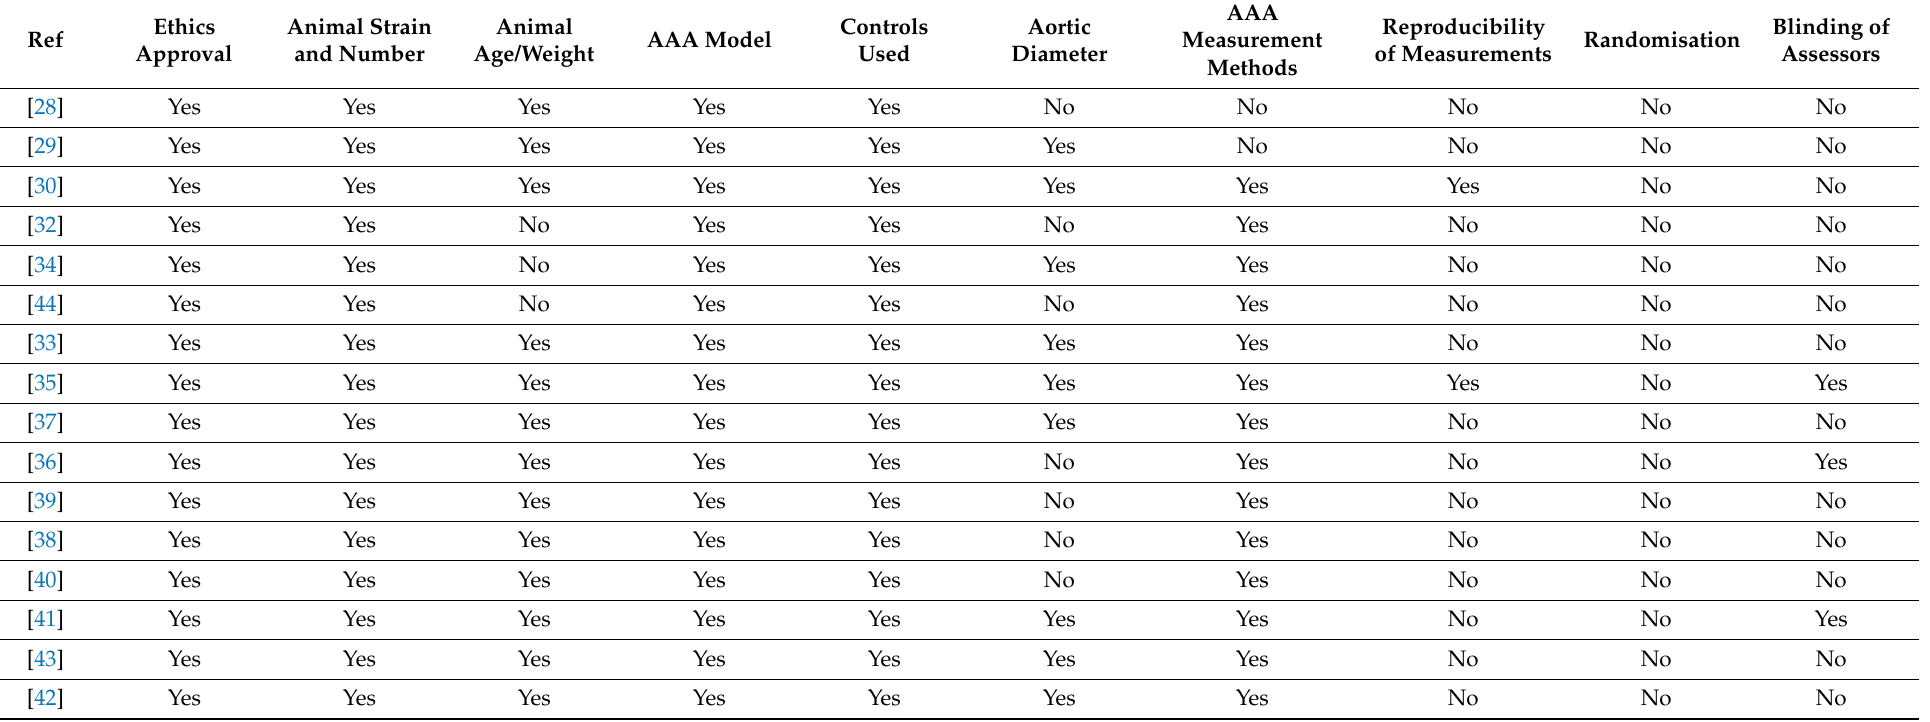
Table 3. Quality of animal studies investigating the effect of tumor necrosis factor or interleukin inhibition in AAA